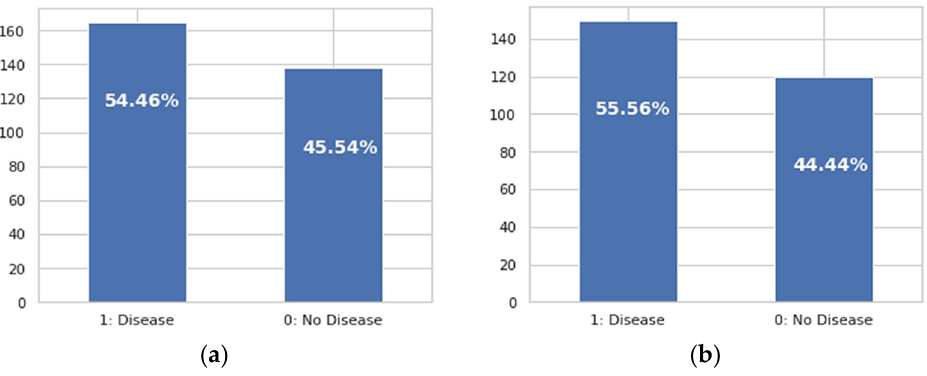
Figure 3. Heart disease classes. ( a ) Cleveland dataset; ( b ) Statlog dataset.